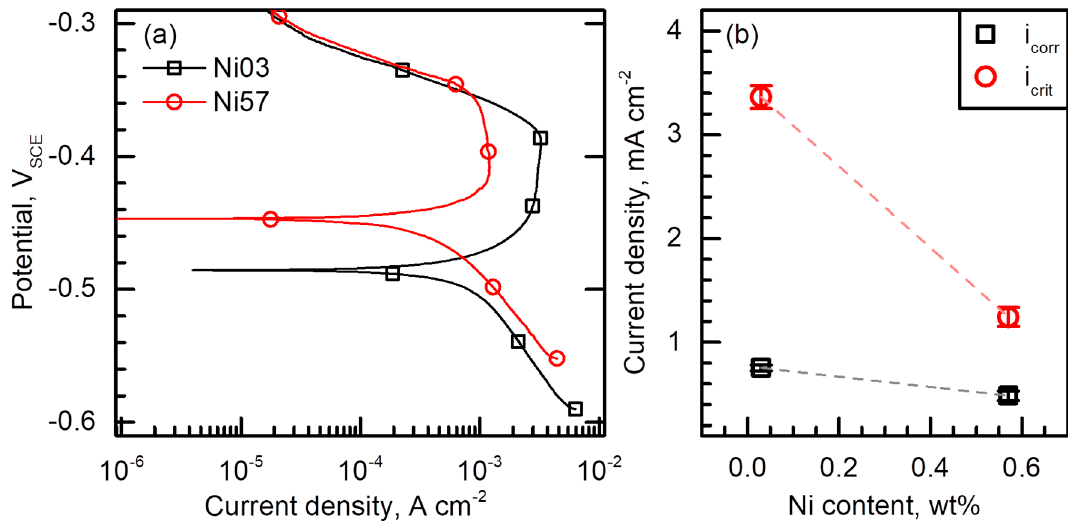
Figure 8. ( a ) Potentiodynamic polarization curves of the Ni03 and Ni57 alloys measured in a 1 M HCl solution at 40 °C with a potential sweep rate of 0.17 mV s − 1 . ( b ) Corrosion rate (i corr ) and critical anodic current density (i crit ) of the alloys.